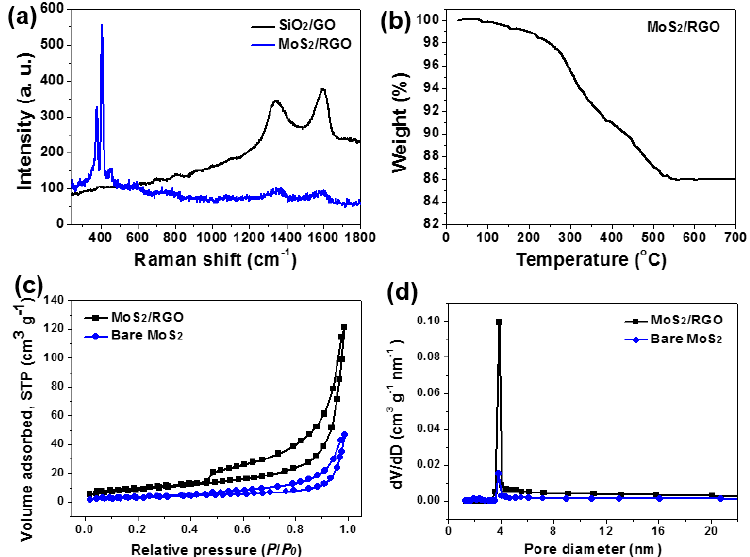
Figure 6. ( a ) Raman spectra of SiO 2 /GOmicrospheres (black curve) and MoS 2 /RGO hollow microspheres (blue curve); ( b ) TGA profile of MoS 2 /RGO hollow microspheres; ( c ) N 2 adsorption–desorption isotherms; as well as ( d ) pore size distributions of MoS 2 /RGO hollow microspheres (black curve) and bare MoS 2 microspheres (blue